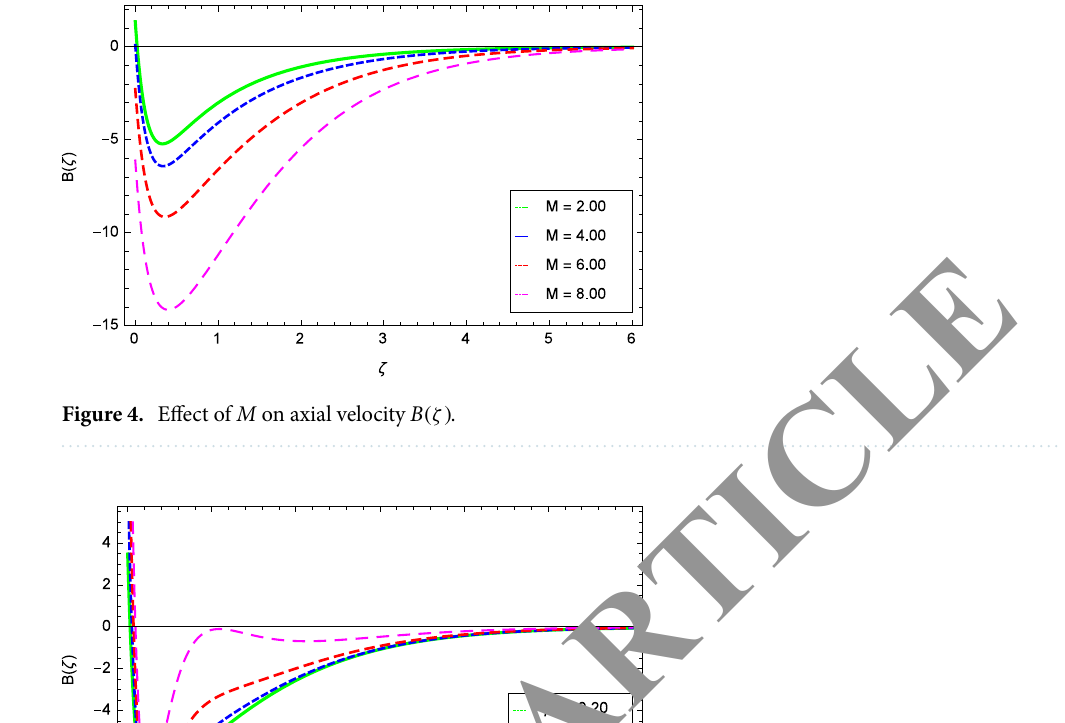
Figure 5. Effect of p 1 on axial velocity B (ζ) .